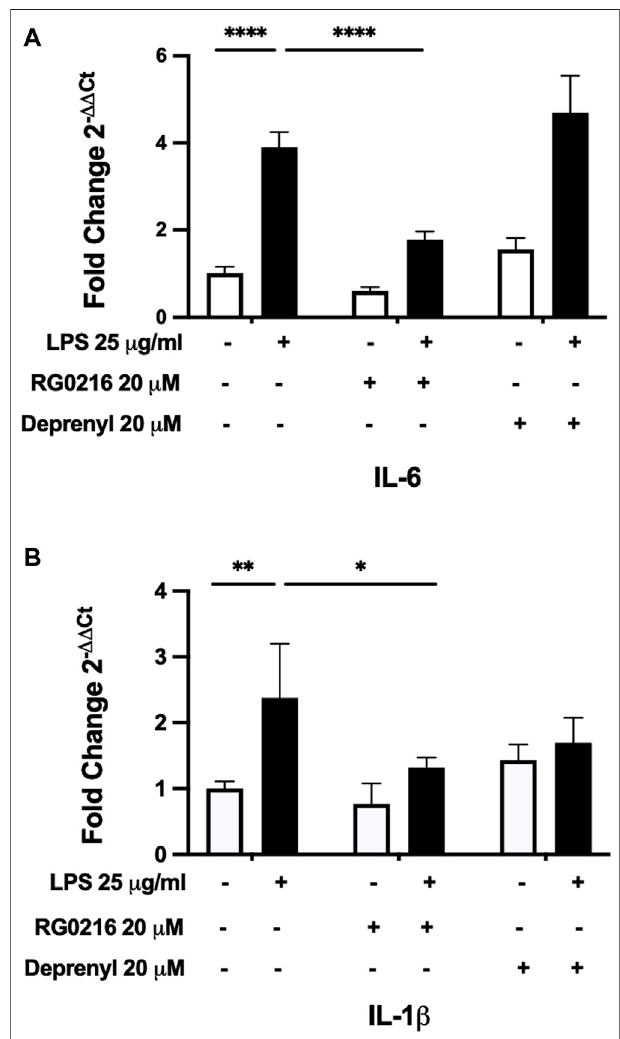
FIGURE 3 | RG0216 and deprenyl regulation of LPS-induced IL-6 and IL-1 β gene expression. Neither IL-6 (A) nor IL-1 β (B) gene expression in control cultures (white bar) were signi fi cantly altered by RG0216 or deprenyl. LPS signi fi cantly induced gene expression of both pro-in fl ammatory cytokines (black bars); however, only RG0216 signi fi cantly reduced their gene expression at 4 h. The analysis was done using qRT-PCR. Data presented as mean ± SD ( n (cid:2) 4). * p < 0.05, ** p < 0.01 and **** p <